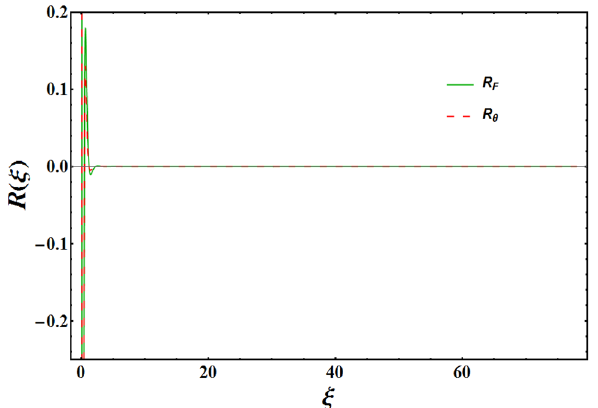
Figure 3. Minimized redidual error